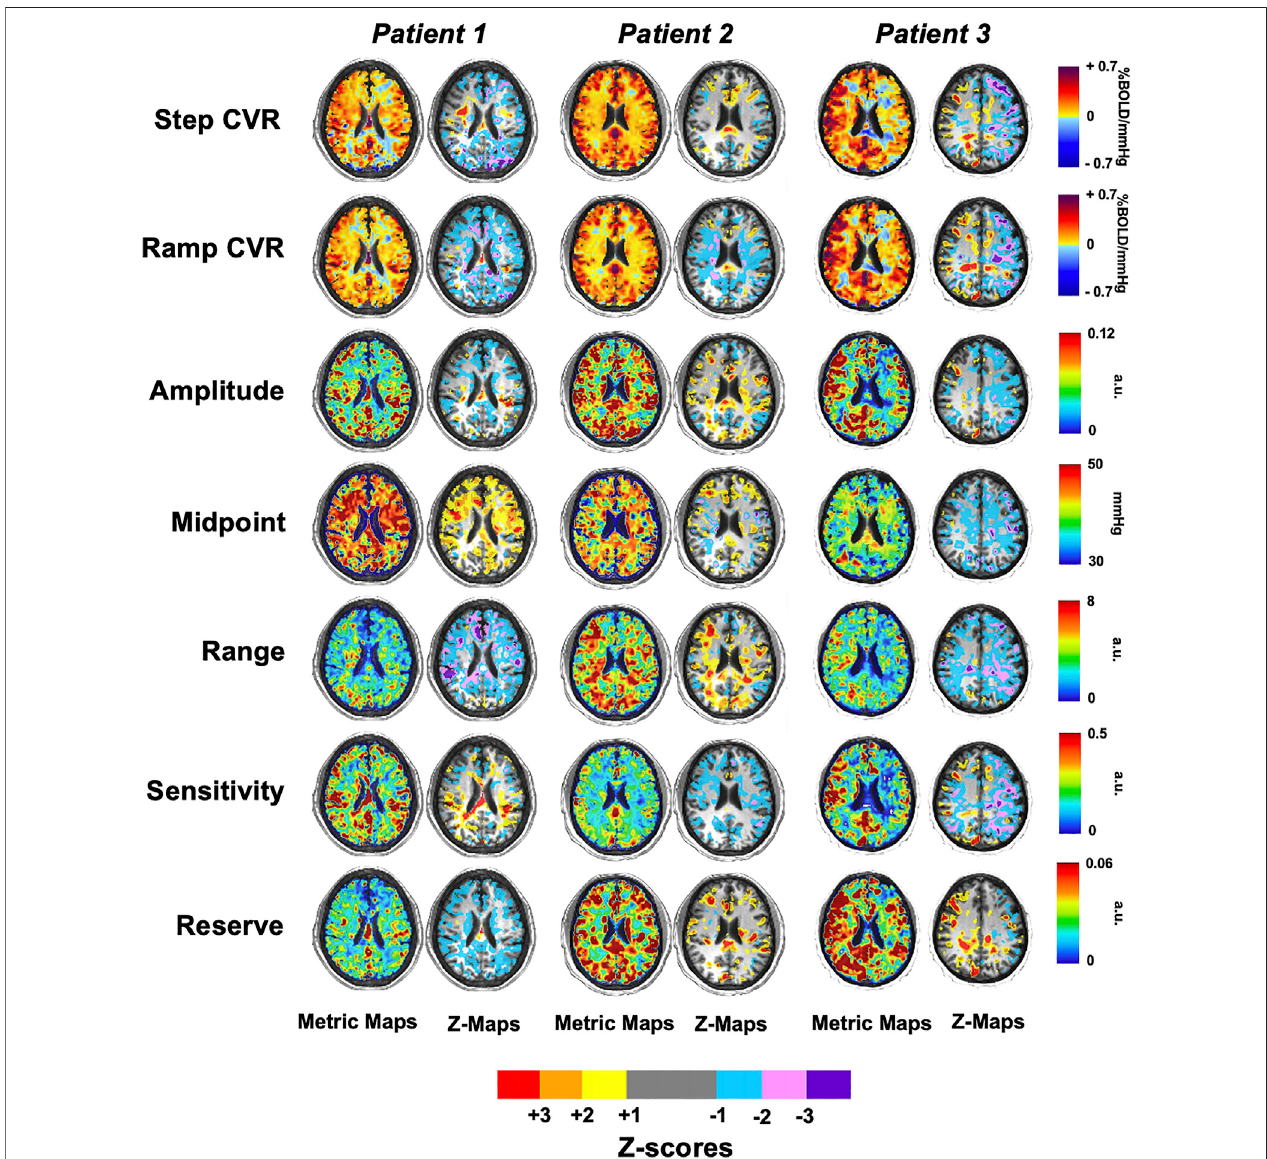
FIGURE 6 | Axial slices of three representative patients with SCD for the CVR and fi ve resistance parameters that were z-scored against the healthy control atlas.